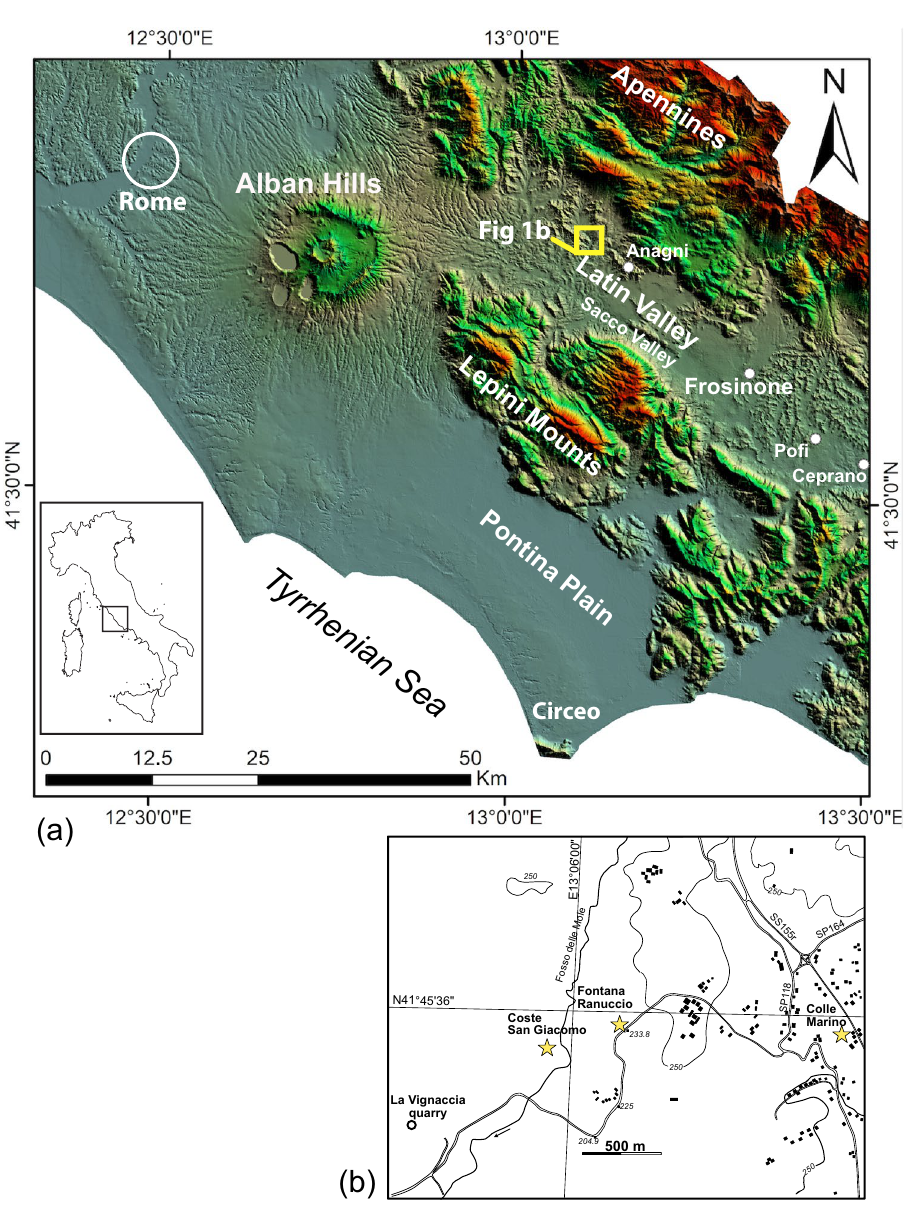
Figure 1. ( a ) Digital Elevation Model (DEM) image TINITALY/01 square WA 6570, of central Italy showing location of the Latin Valley and ( b ) of the investigated archaeological sites. Used with permission of the